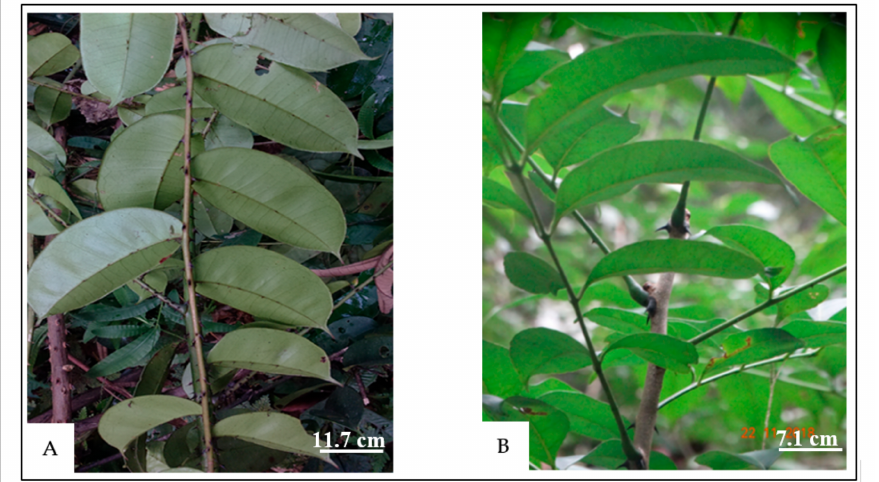
Figure 1. Leaves of Zanthoxylum psammophilum ( A ) and Zanthoxylum mezoneurispinosum ( B